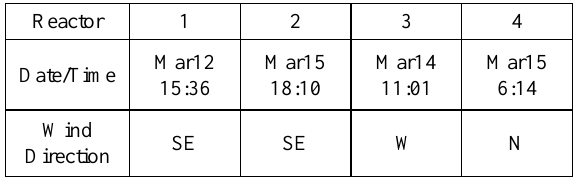
Table 1. Hydrogen explosions and the wind directions